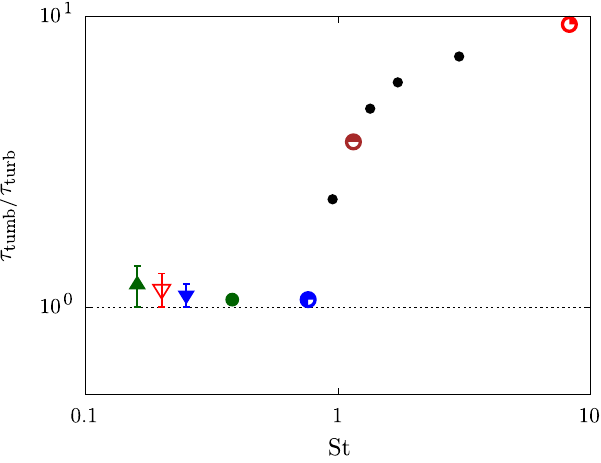
FIG. 2. Ratio between the fiber tumbling time [evaluated from Eq. (3)] and the eddy turnover time at the fiber length scale [evaluated from Eq. (7)] as a function of the Stokes number. Colored bullets refer to the simulation data, while colored triangles are the experimental data. Coloring and symbols correspond to the values of St used also in the following figures.